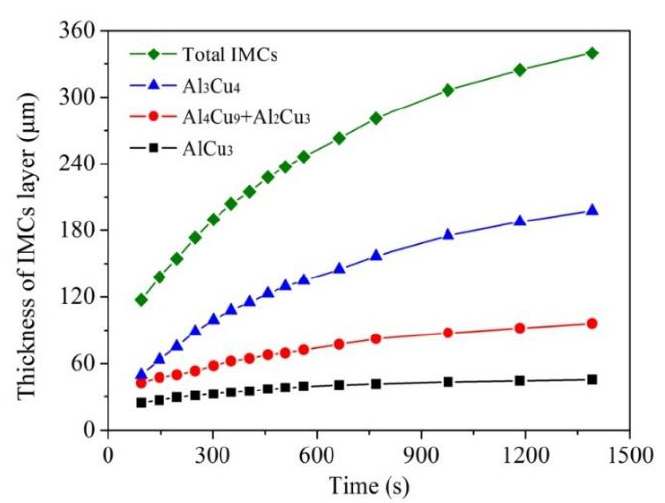
Figure 8. The time dependence of the thickness of IMCs layers.